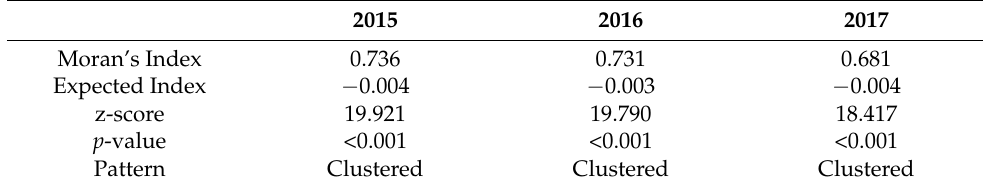
Table 2. Global Moran’s I of annual mean PM2.5.